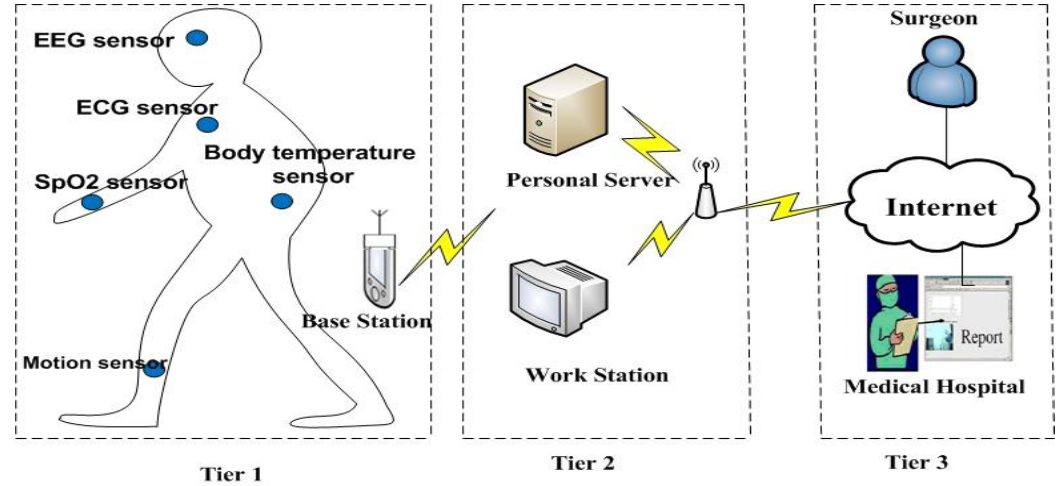
Figure 1. Body Sensor Network Architecture, with the permission form